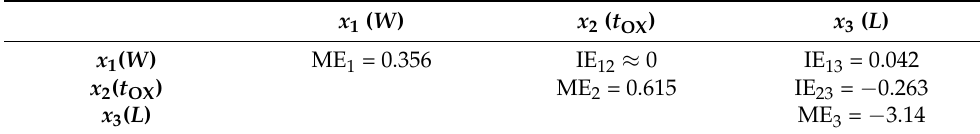
Table 5. f MAX main effects and interaction effects.